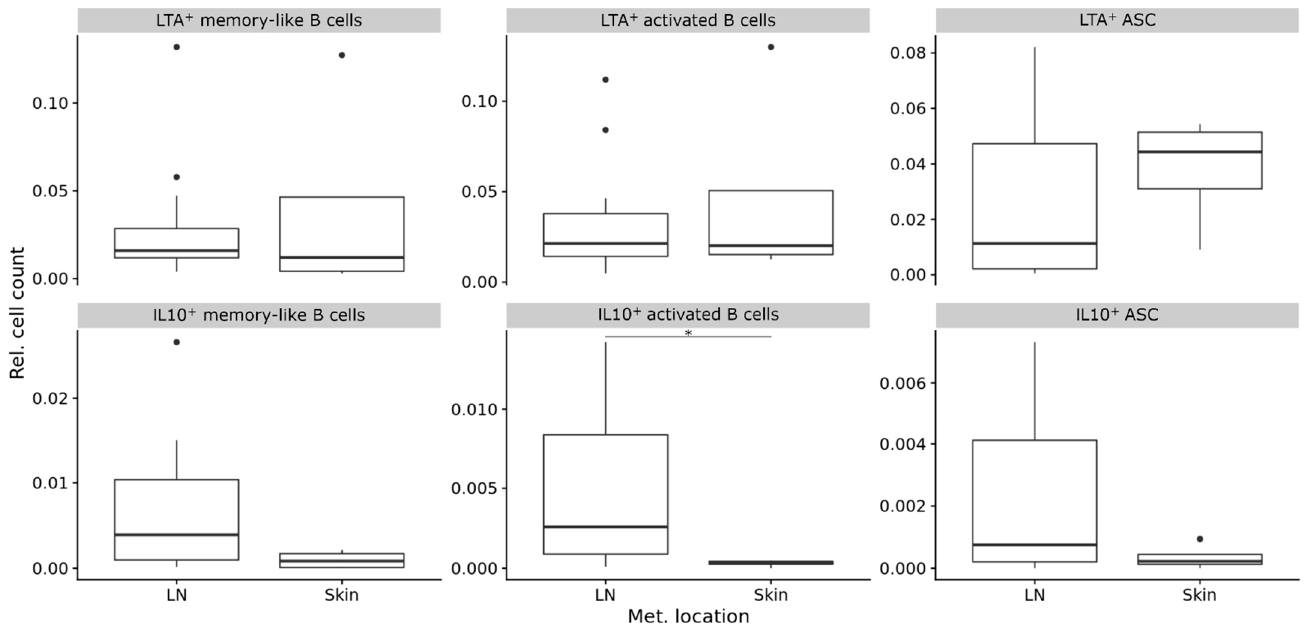
Figure 4. Composition (relative frequencies) of LTA + and IL-10 + B cell subpopulations in metastatic tumor sites. Boxplots comparing metastatic lymph node (LN) and skin sites. In boxplots, lower and upper hinges correspond to the first and third quartiles and center lines to medians. Lower and upper whiskers extend from the hinge to the largest value within 1.5 times the interquartile range. Outliers are shown as black circles. * p ≤ 0.05. ASC = antibody secreting cells.